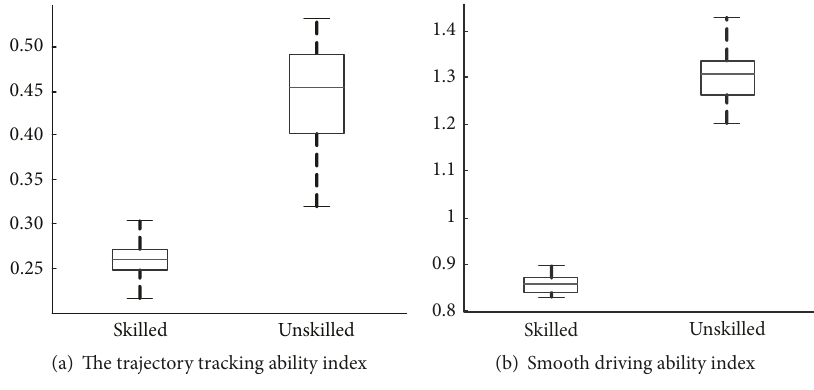
Figure 3: The trajectory tracking and smooth driving